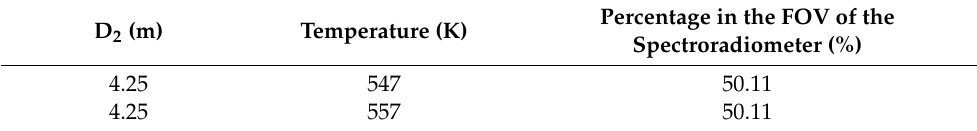
Table 1. FOV nonuniformity correction verification scheme.